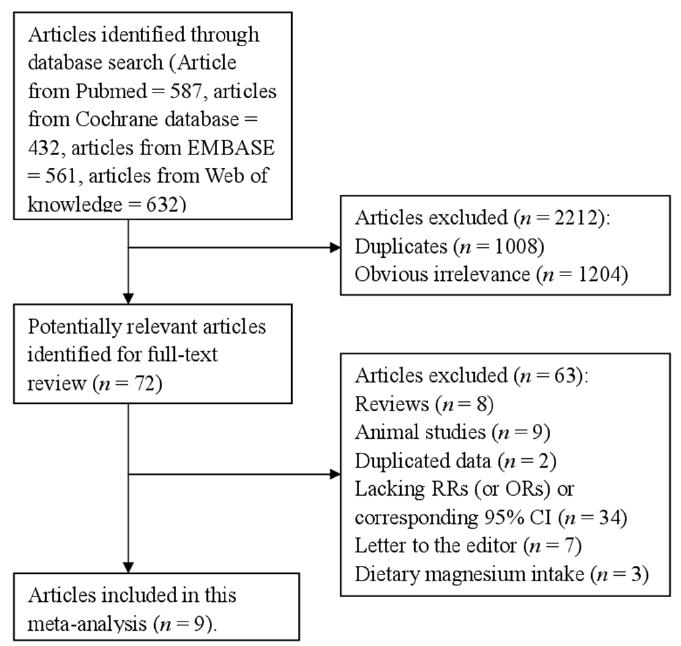
Figure 1. The flow diagram of screened, excluded, and analyzed publications.